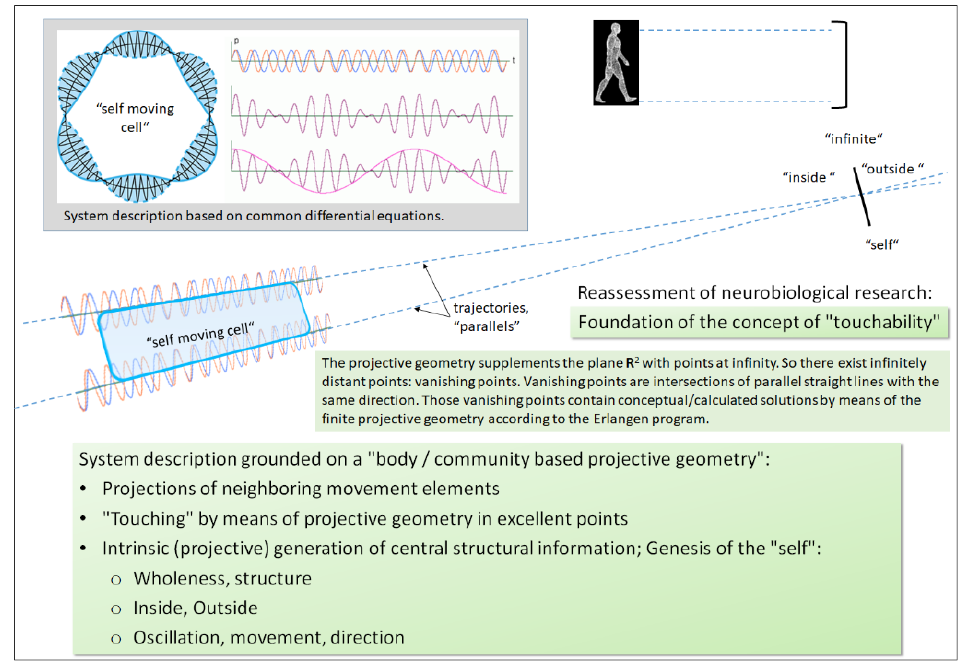
Figure 1. System description of living beings. Their dynamics are reflected in a multitude of oscillation forms. Above: In deterministic thinking, the dynamics are “trapped” in a circular process ( top left ) or determined deterministically as if on a fixed path ( top right ). The system description is carried out using common differential equations. According to this point of view, a person walking covers a distance but remains structurally unchanged. So everything runs on given paths; the movement has no future or prospects. Below: Illustration of how a finite projective geometry according to the Erlangen program makes the phenomenon of self-movement clear in a new way: Simple series of atomic movements meet through a “body’s own” projective geometry in an “infinite” way that for the moving body the central information of “inside” and “outside” is generated.